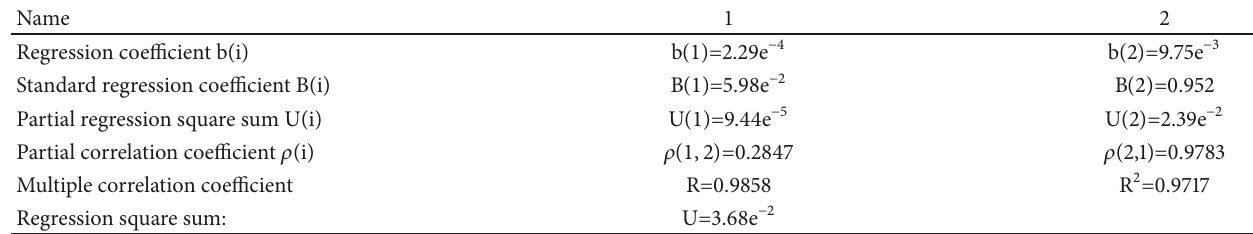
Table 5: Regression analysis